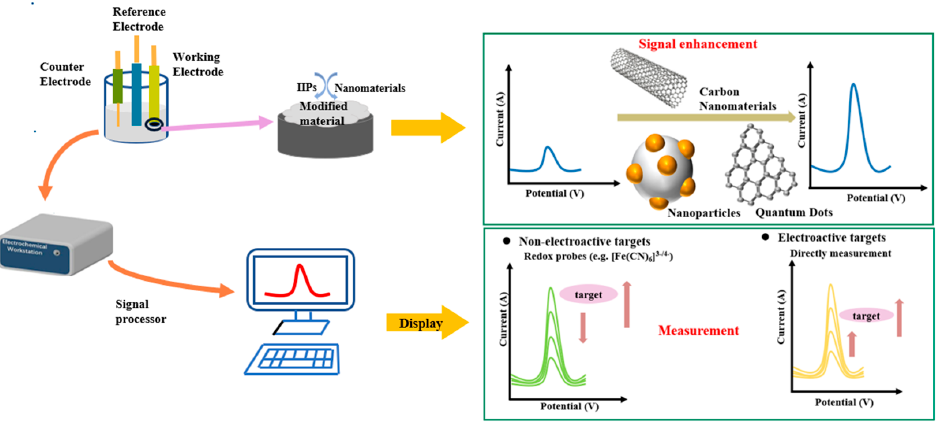
Figure 2. Construction and detection principle of HMIIECSs. Adapted with permission from Ref. [57]. Copyright 2021, Elsevier.